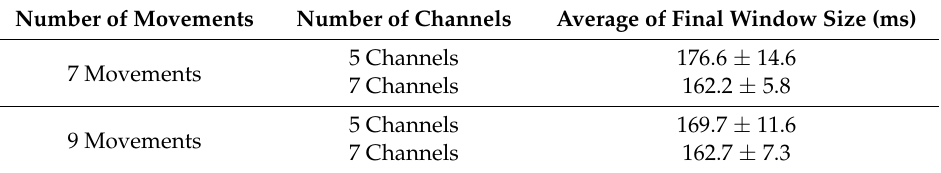
Table 4. Mean ± SD of the final window size when tested with the test set ( evaluation phase ) in ms with the standard deviation for all 9 amputees with TD-PSD FE method.